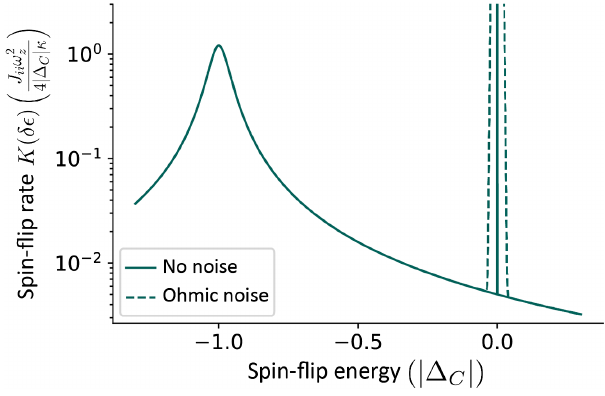
FIG. 15. The spin-flip rate function for an Ohmic noise source. − 2 MHz has a width set The Lorentzian peak centered at Δ C ¼ by κ ¼ 150 kHz and provides cooling, while the peak at zero causes heating if the noise source broadens it too much. Plotted is the spin-flip rate function with no noise source (solid line), in which the central peak is a zero-width delta function, and with a classical Ohmic noise sufficient to completely suppress super- positions of S x states of up to M ¼ 10 4 spins per ensemble (dashed line). The rate functions overlap away from the point of zero spin-flip energy. The central peak is broadened but still remains small compared to the typical spin-flip energy ≲ Δ ; as C such, it does not interfere with the cooling